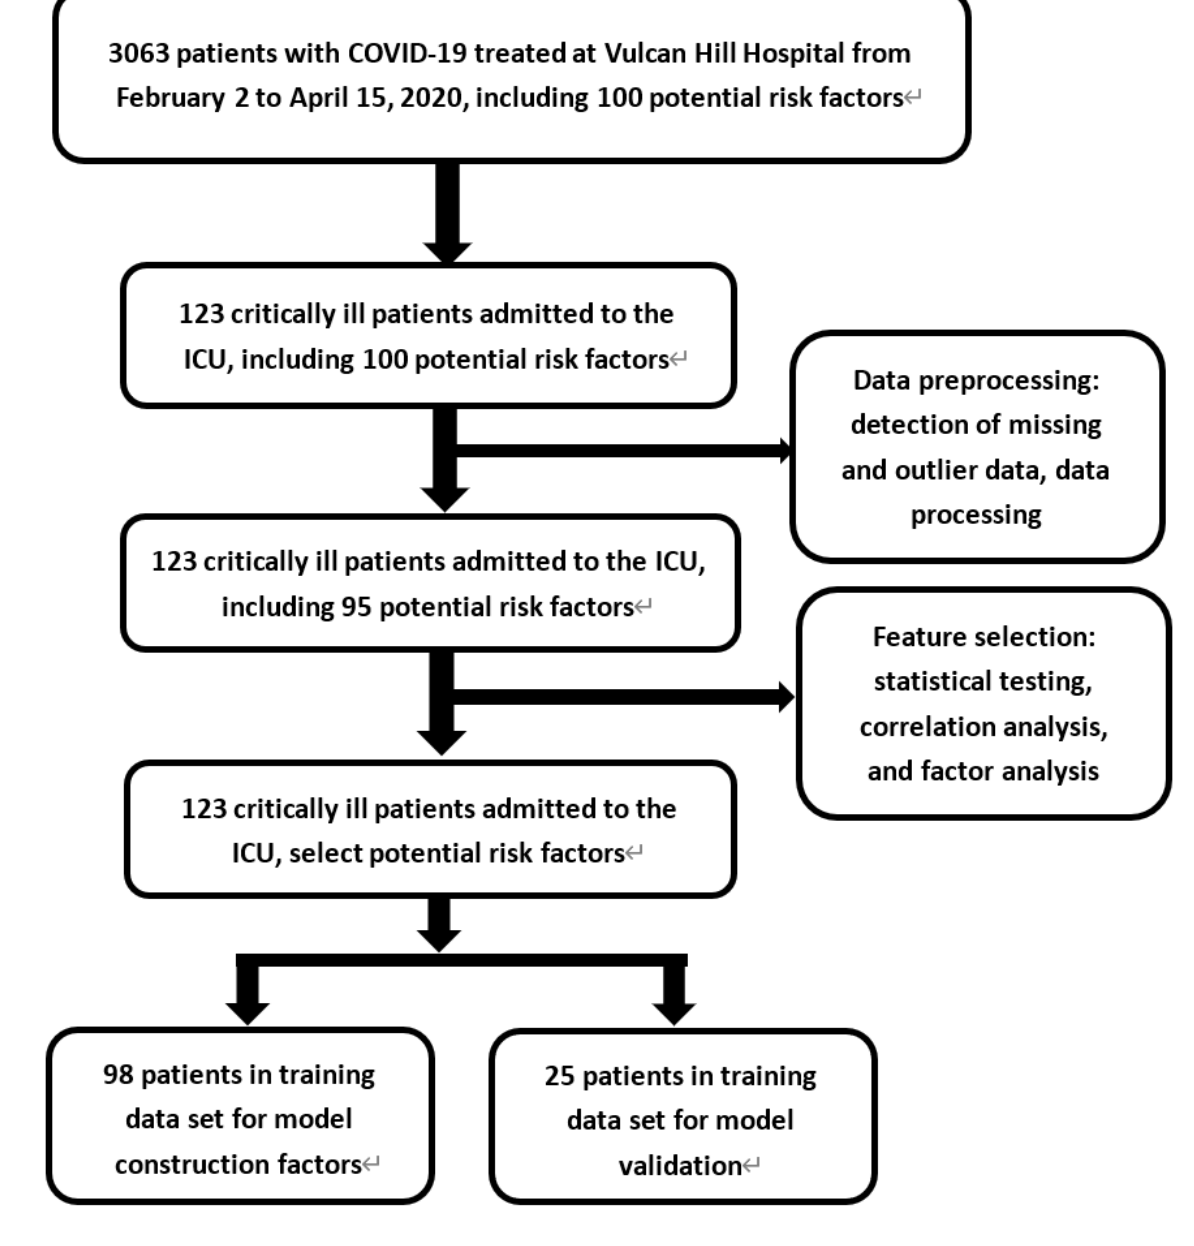
Figure 2. Flowchart of the data and feature